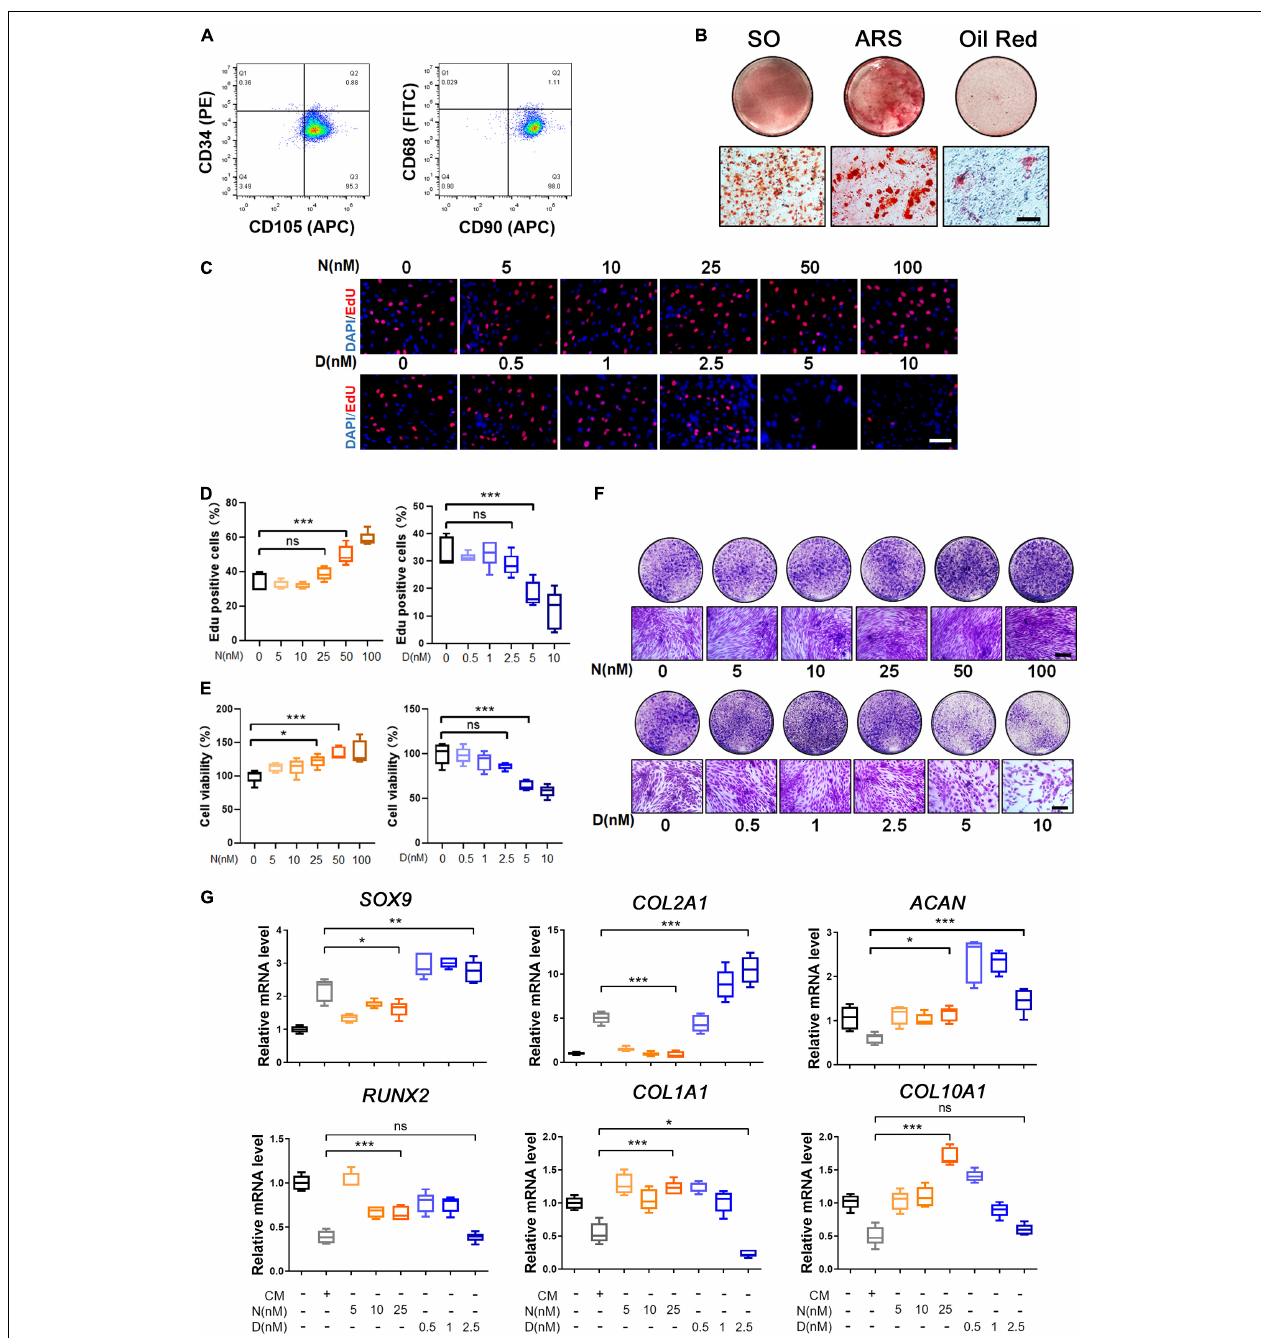
FIGURE 1 | Characterization and trilineage differential potency of SMSCs from osteoarthritis (OA) keen synovium. (A) Surface marker expression of synovial mesenchymal stem cells (SMSCs). Results showed negativity for hematopoietic marker (CD34) and macrophage marker (CD68) and showed positivity for mesenchymal stem cell (MSC) markers like CD105 and CD90. (B) Multi-directional differentiation of SMSCs; chondrogenesis was accessed by safranin O staining (SO), osteogenesis was accessed by alizarin red S staining (ARS), and adipogenesis was accessed by Oil red O staining. (C) The EdU staining of SMSCs after the treatment of different concentrations of nocodazole (N) (5, 10, 25, 50, 100 nM) and docetaxel (D) (0.5, 1, 2.5, 5, 10 nM) in chondrogenic medium (CM) for 1 week. Scale bar, 100 µ m. (D) Quantification of the data of (C) . n = 5. (E) The cell viability of SMSCs after the treatment of different concentrations of nocodazole (N) (5, 10, 25, 50, 100 nM) and docetaxel (D) (0.5, 1, 2.5, 5, 10 nM) in chondrogenic medium (CM) for 1 week. (F) Crystal violet staining of SMSCs after the treatment of different concentrations of nocodazole (N) (5, 10, 25, 50, 100 nM) and docetaxel (D) (0.5, 1, 2.5, 5, 10 nM) in chondrogenic medium (CM) for 1 week. Scale bar, 100 µ m. (G) RT-qPCR analyses of SOX9 , COL2A1 , ACAN , RUNX2 , COL1A1 , and COL10A1 in SMSCs treated with nocodazole (N) and docetaxel (D) in chondrogenic medium (CM) for 1 week. 2.5 nM of docetaxel had significant effects on chondrogenesis in SMSCs. Data are represented as the mean ± SEM. * p < 0.05, ** p < 0.01, *** p <